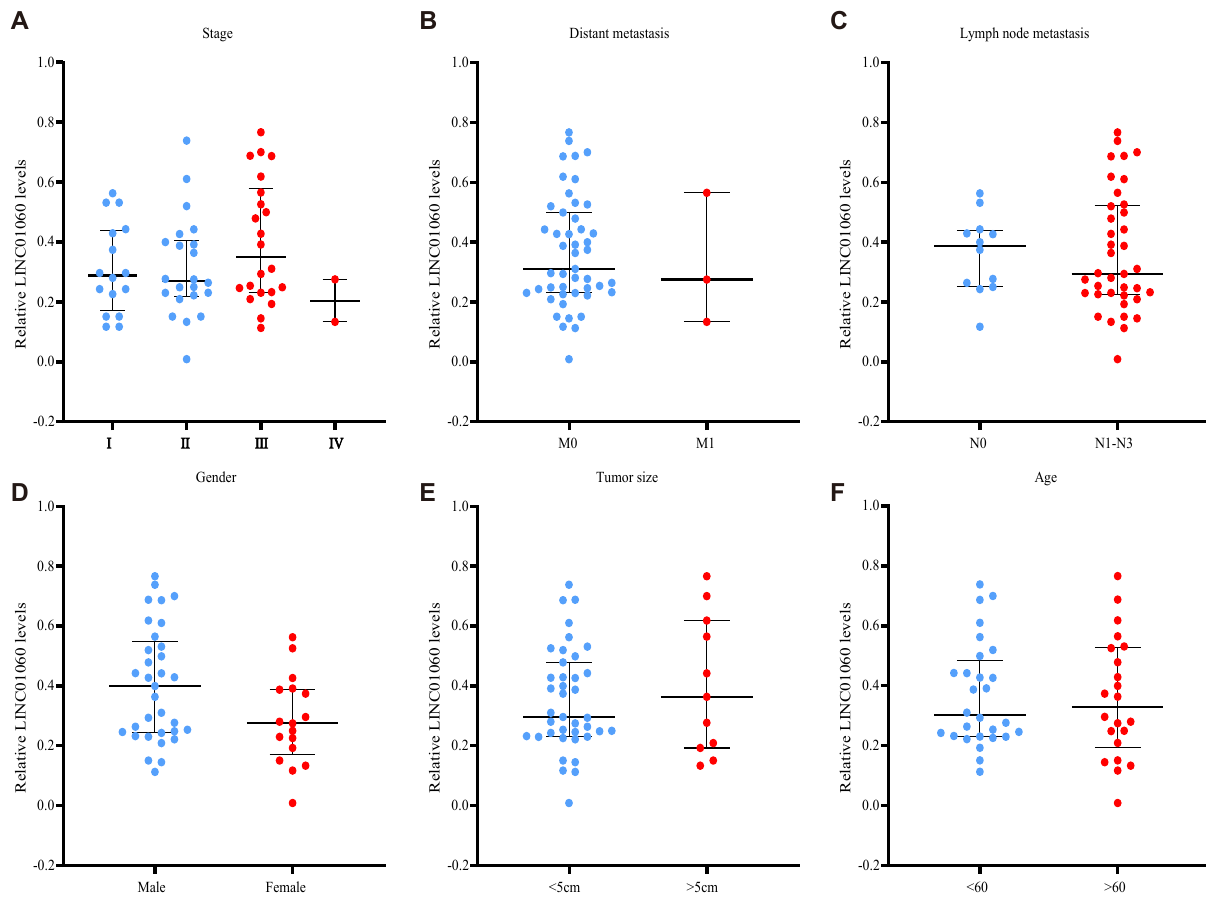
Figure 5: Association between LINC01060 expression and clinical characteristics of gastric cancer patients. The characteristics included (A) cancer stages, (B) distant metastasis, (C) lymphatic invasion, (D) gender, (E) tumor size, and (F) age